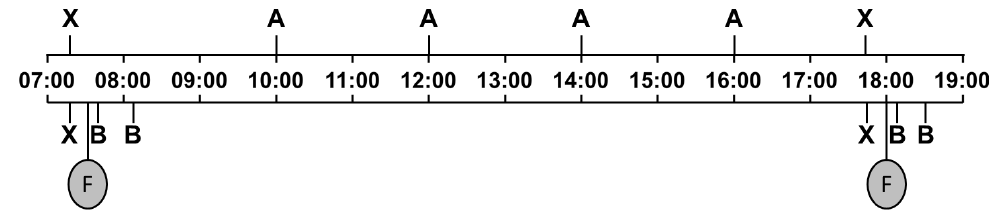
Figure 2. Schedule for saliva sampling in calves. F, morning and evening milk feeding (07:30 h and 18:00 h); A, saliva sampling to determine circadian rhythm at fixed times of day; B, saliva sampling to determine effect of feeding, 5 and 30 min after the end of milk feeding; X, saliva sampling serving both purposes.